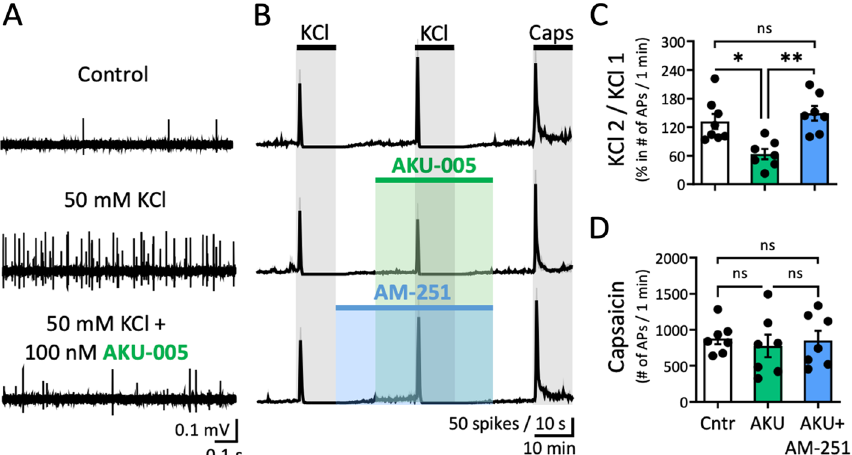
Fig. 4 Dual MAGL/FAAH inhibitor AKU‑005 reduces nociceptive firing mediated by CB1 receptors. A Example traces of APs recorded from the peripheral part of trigeminal nerve innervating rat meninges for the control condition before any application (top), during the 1‑min active phase of KCl‑induced spiking activity without (middle) and in the presence of AKU‑005 (100 nM) (bottom trace). B Time courses of spike frequency (10‑s bin size) induced by two subsequent 10‑min pulses of 50 mM KCl and 1 μM Capsaicin, in the presence of only 100 nM AKU‑005 and the combination of 100 nM AKU‑005 and 1 μM AM‑251 during the 2 nd KCl pulse. After exposure to AKU‑005, the 2 nd KCl‑induced firing was reduced. To test that the effect was mediated by cannabinoid CB1 receptors, the experiment was repeated in the presence of specific CB1 blocker AM‑251 (1 µM). C Firing induced during the 2 nd KCl pulse was reduced in the presence of AKU‑005 (AKU) application ( N 7, Kruskal Wallis test, * 0.03) in comparison to = = the control ( N 8) condition (Cntr) (the ratio of the APs between 2 nd and 1 st KCL pulse). Firing was increased again by the combination of both = AM‑251 and AKU‑005 ( N 7, Kruskal Wallis test, ** 0.004). D Blockade of CB1 receptors did not change the efficacy of next applied capsaicin = = compared to application of only AKU‑005 (number of APs/1